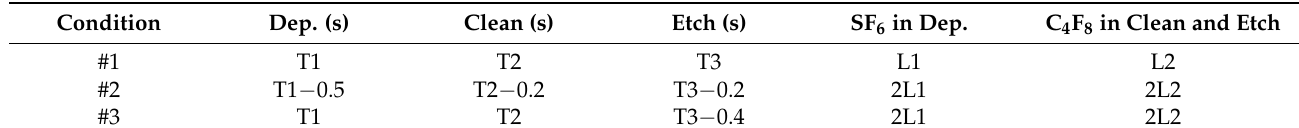
Table 1. TSV etch conditions with different process parameters.